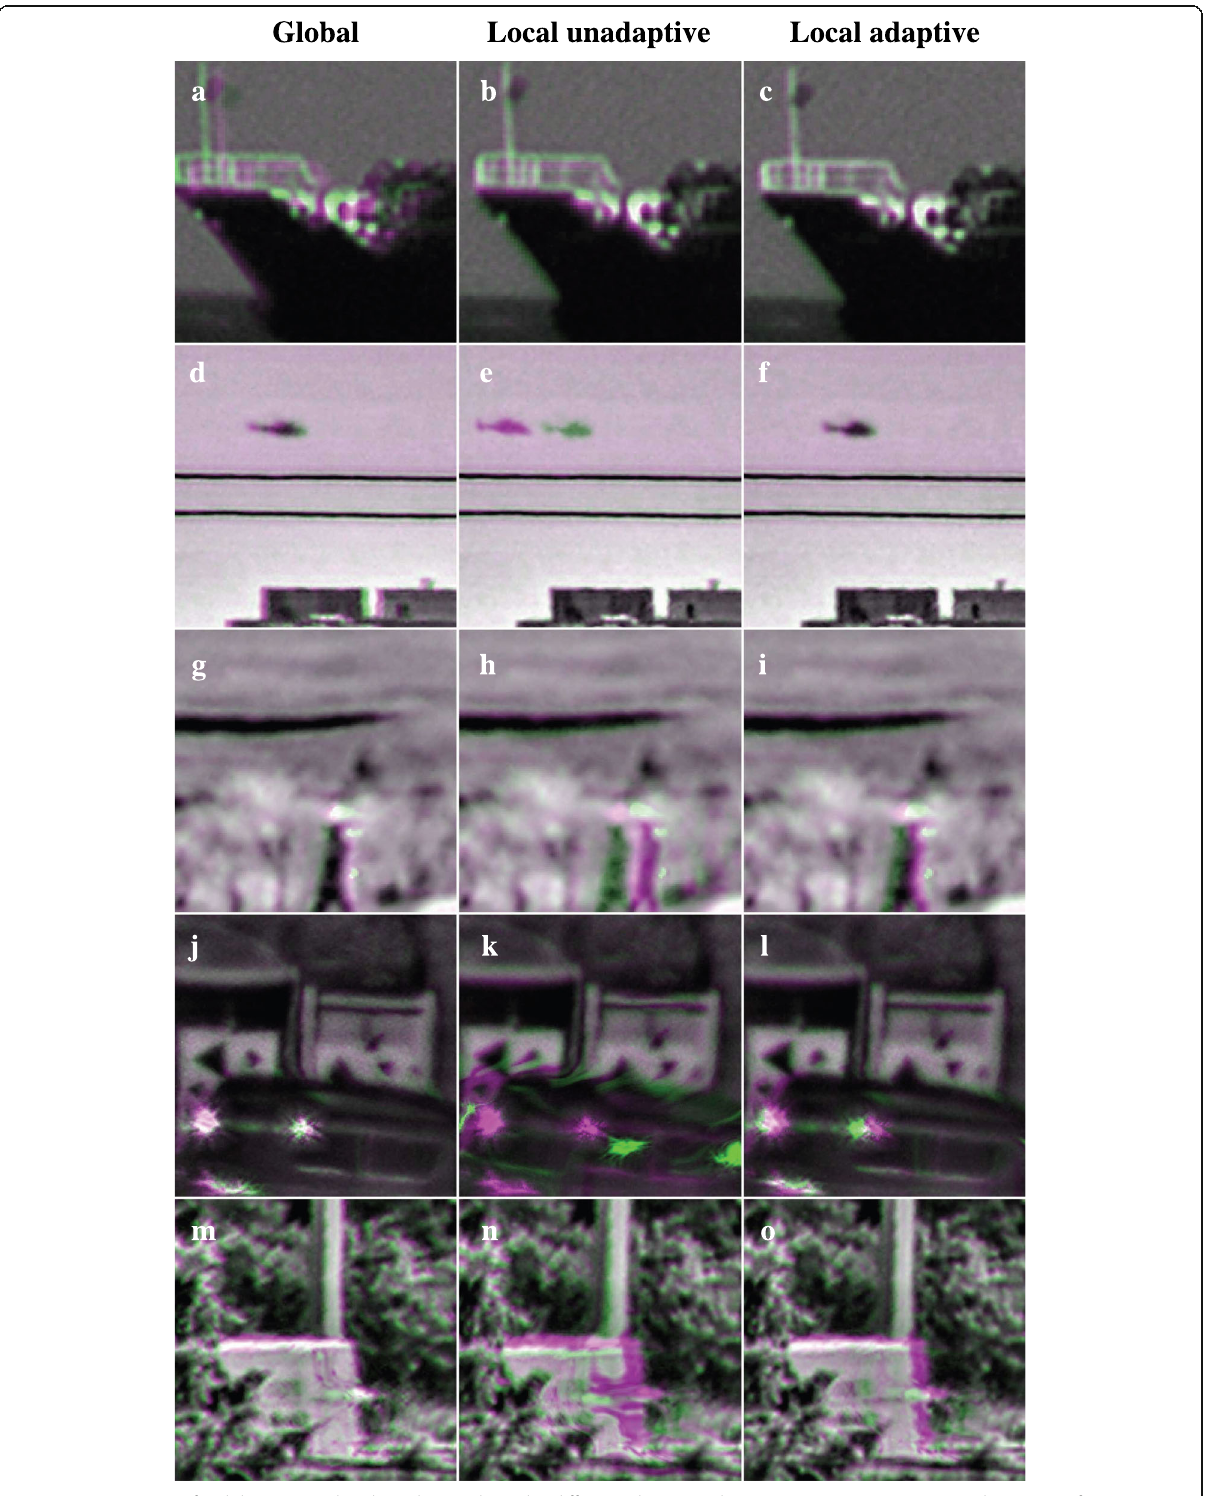
Fig. 15 Comparison of stabilization results. The columns show the difference between the current output (magenta) and raw input frame (green) for respectively global stabilization ( a , d , g , j , m ), local unadaptive stabilization with a fixed update rate according to Eq. 5 ( b , e , h , k , n ), and local adaptive local adaptive stabilization with a variable update rate according to Eq. 6 ( c , f , i , l , o